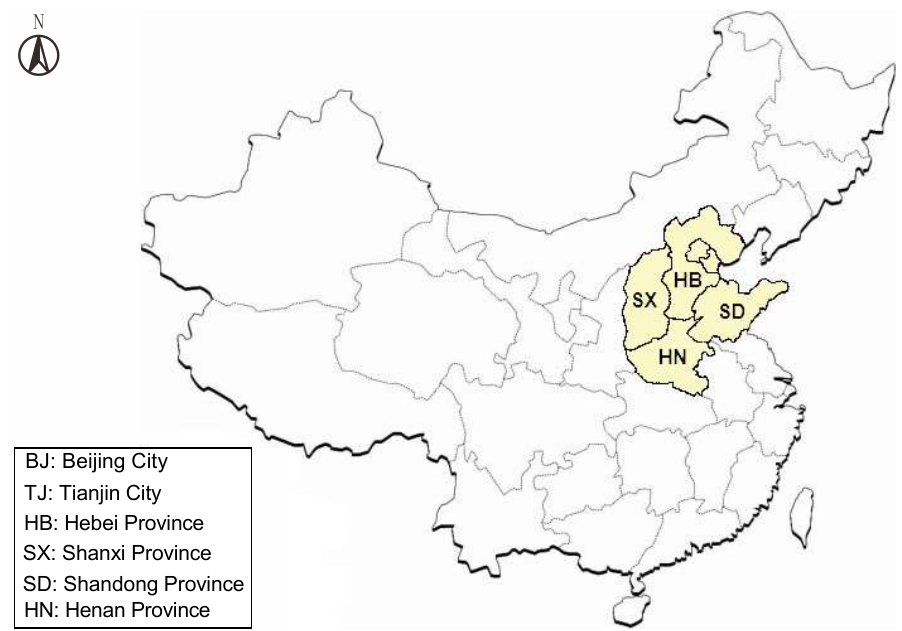
Figure 4. Location of evaluation